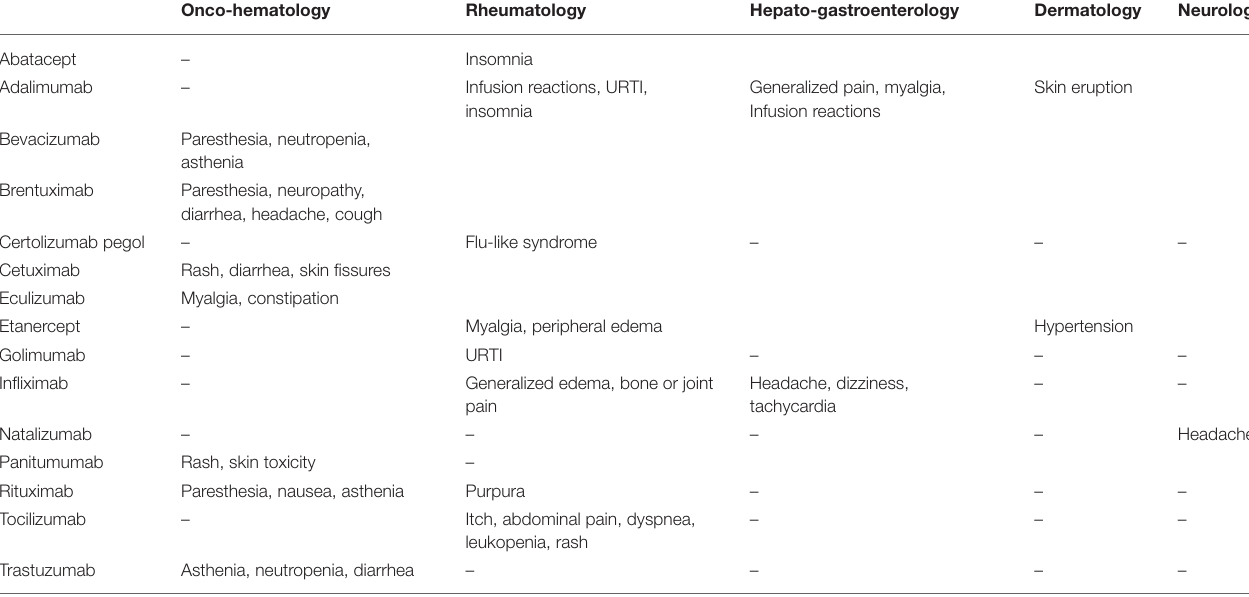
TABLE 4 | AE/biotech drug association reported more than once during the study period by Clinical